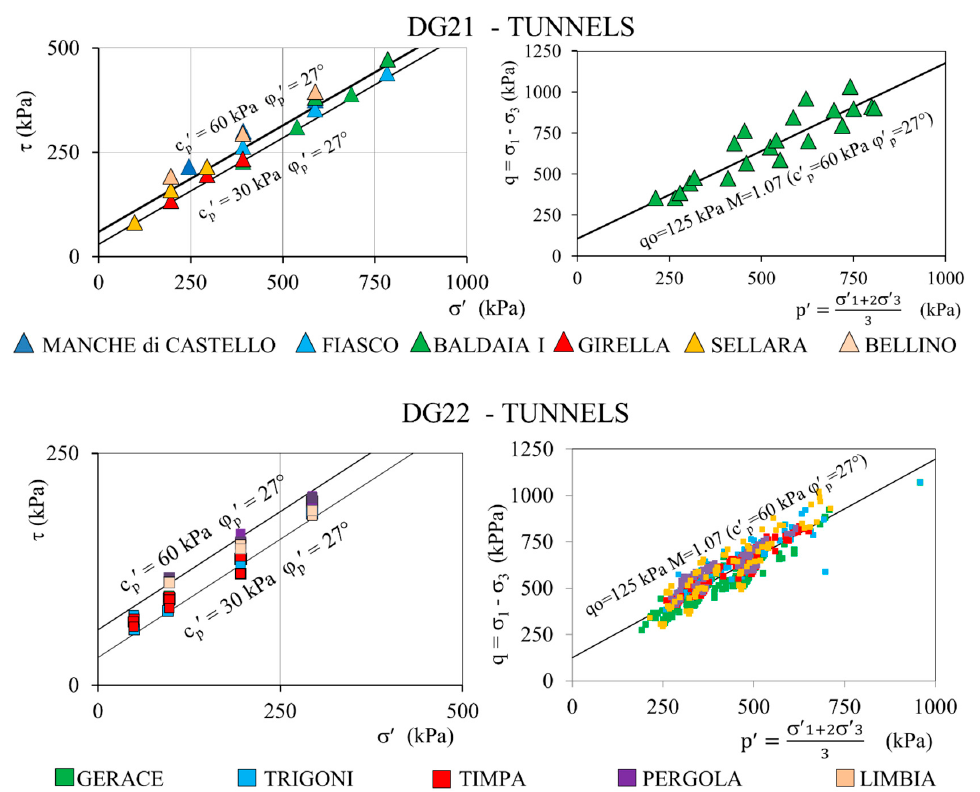
Figure 4. Peak shear strength obtained by laboratory tests on undisturbed samples from the DG21 and DG22 maxi lots.